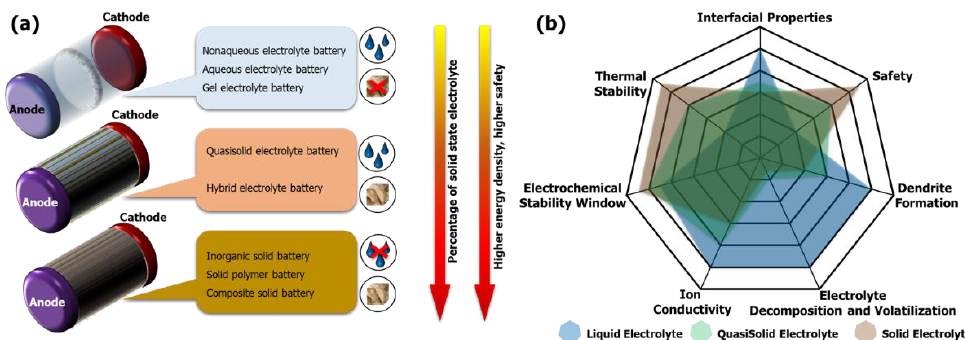
Figure 7. ( a ) Schematic illustration and ( b ) radar chart of three types of batteries based on the liquid content and SSE percentage in the assembled batteries.